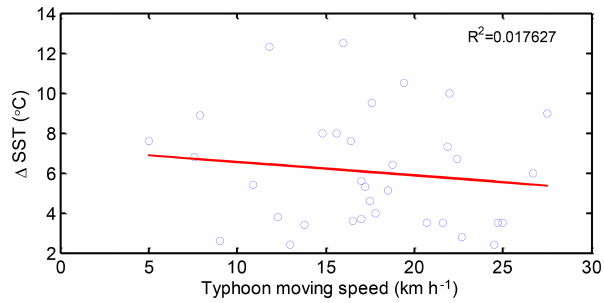
Figure 7. The correlation of typhoon moving speed with (cid:49)